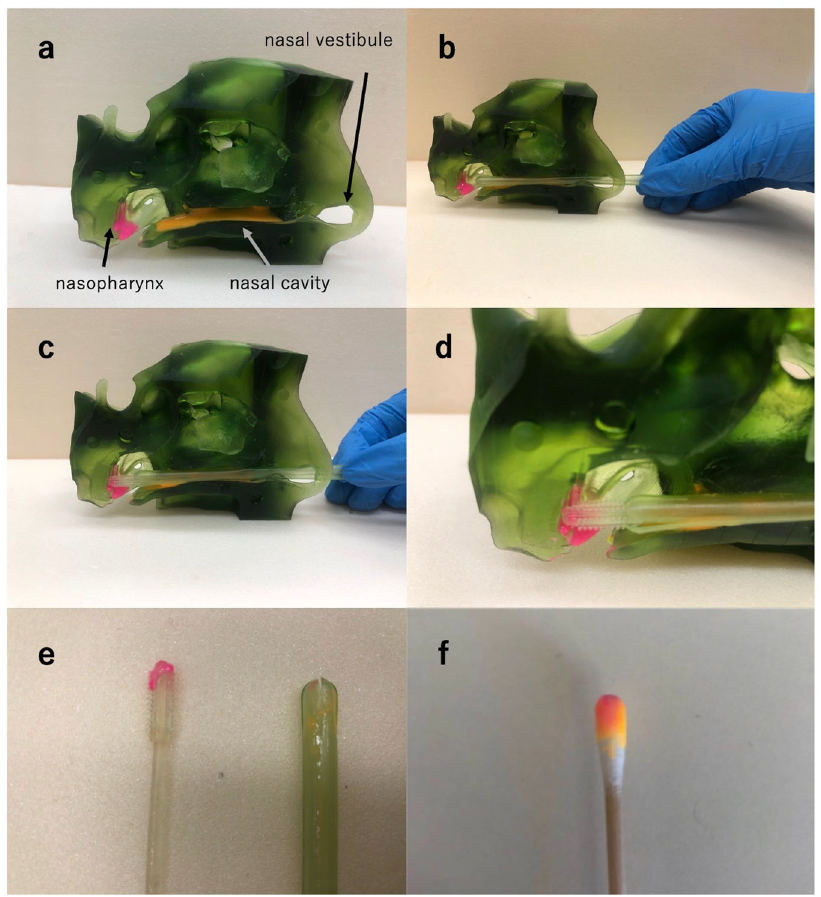
Fig. 10 Collection process of mucus-like material. a Applied mucus (pink is arti fi cial mucus representing target nasal secretions; orange is arti fi cial mucus representing non-target nasal secretions with fewer virus particles). b The 3D-printed swab with cover is horizontally inserted. c The swab is inserted further to extract mucus from the nasopharynx. d Partial detail of the nasopharynx. e The 3D- printed swab tip only picked up pink-colored mucus, and the cover has orange- and pink- colored mucus on the surface. f The normal cotton swab tip picked up both orange- and pink-colored